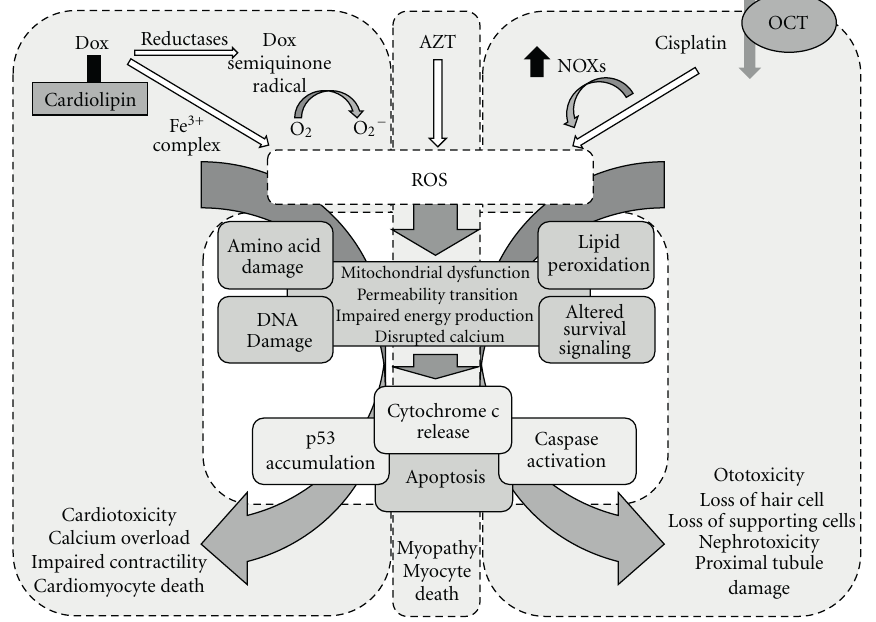
Figure 3: Molecular and cellular events by which oxidative stress in response to Dox, AZT, and cisplatin may result in toxicity. Dox, AZT, and cisplatin accumulation in cells may result in elevations in intracellular ROS. Dox may accumulate in cardiac cells by association with cardiolipin and generate ROS via reduction of molecular oxygen by the semiquinone free radical or by an iron II-Dox radical. Cisplatin may be transported into cells via the OCT transporters (e.g., in renal tubule cells) and elevate ROS levels via induction of NOXs. At the molecular level, ROS damage amino acids, lipid, and DNA. Mitochondrial dysfunction and associated alterations in energetics, together with e ff ects on survival/apoptotic signaling cascades may lead to a proapoptotic response. These common mechanisms may be key to Dox-dependent cardiotoxicity, AZT-dependent skeletal myopathy, and cisplatin-dependent nephrotoxicity and ototoxicity described further in Section 3.